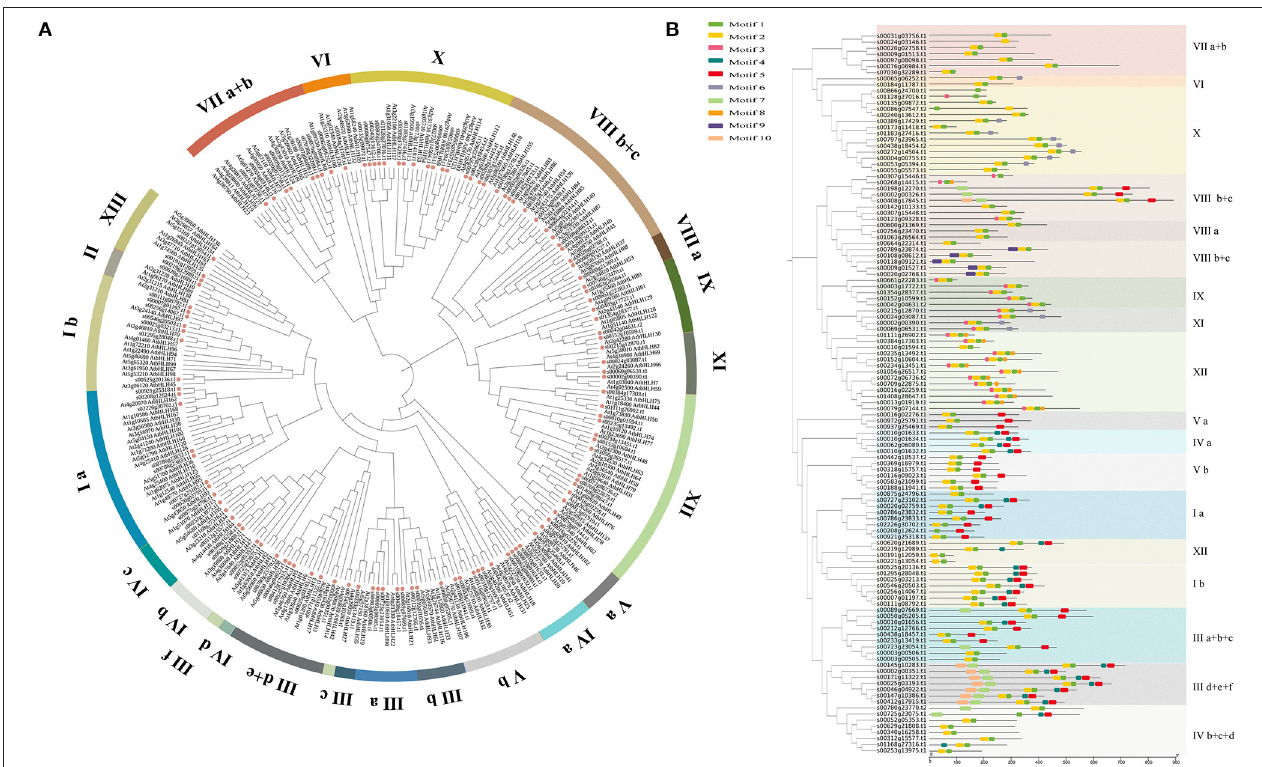
FIGURE 1 | Phylogenetic tree and conserved motif analysis of FcbHLHs. (A) The 25 subgroups are marked in different colors on the periphery of the circle. Pink dots indicate fig bHLH proteins. The phylogenetic tree was constructed using MEGA6, with bootstrap values based on 1,000 iterations. (B) Rootless neighbor-joining (NJ) phylogenetic tree of 118 full-length amino acid sequences of FcbHLH proteins. The 25 subgroups are marked with different background colors. Conserved motifs are represented by different colored boxes.